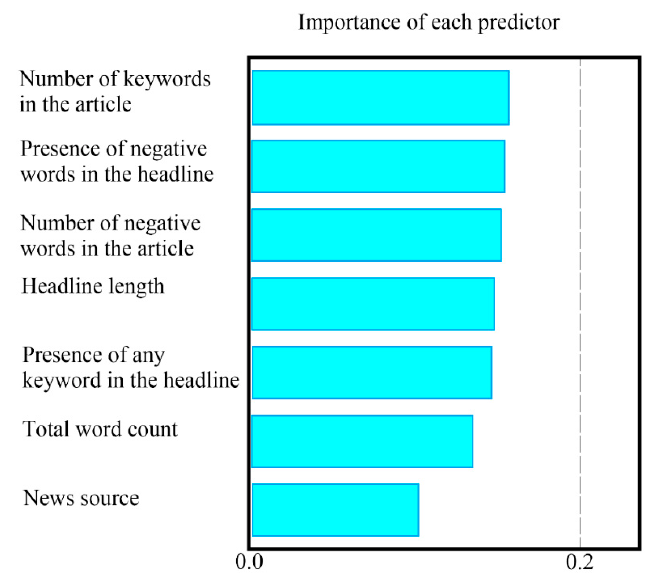
Figure 4. The importance of each predictor in the decision tree analysis.